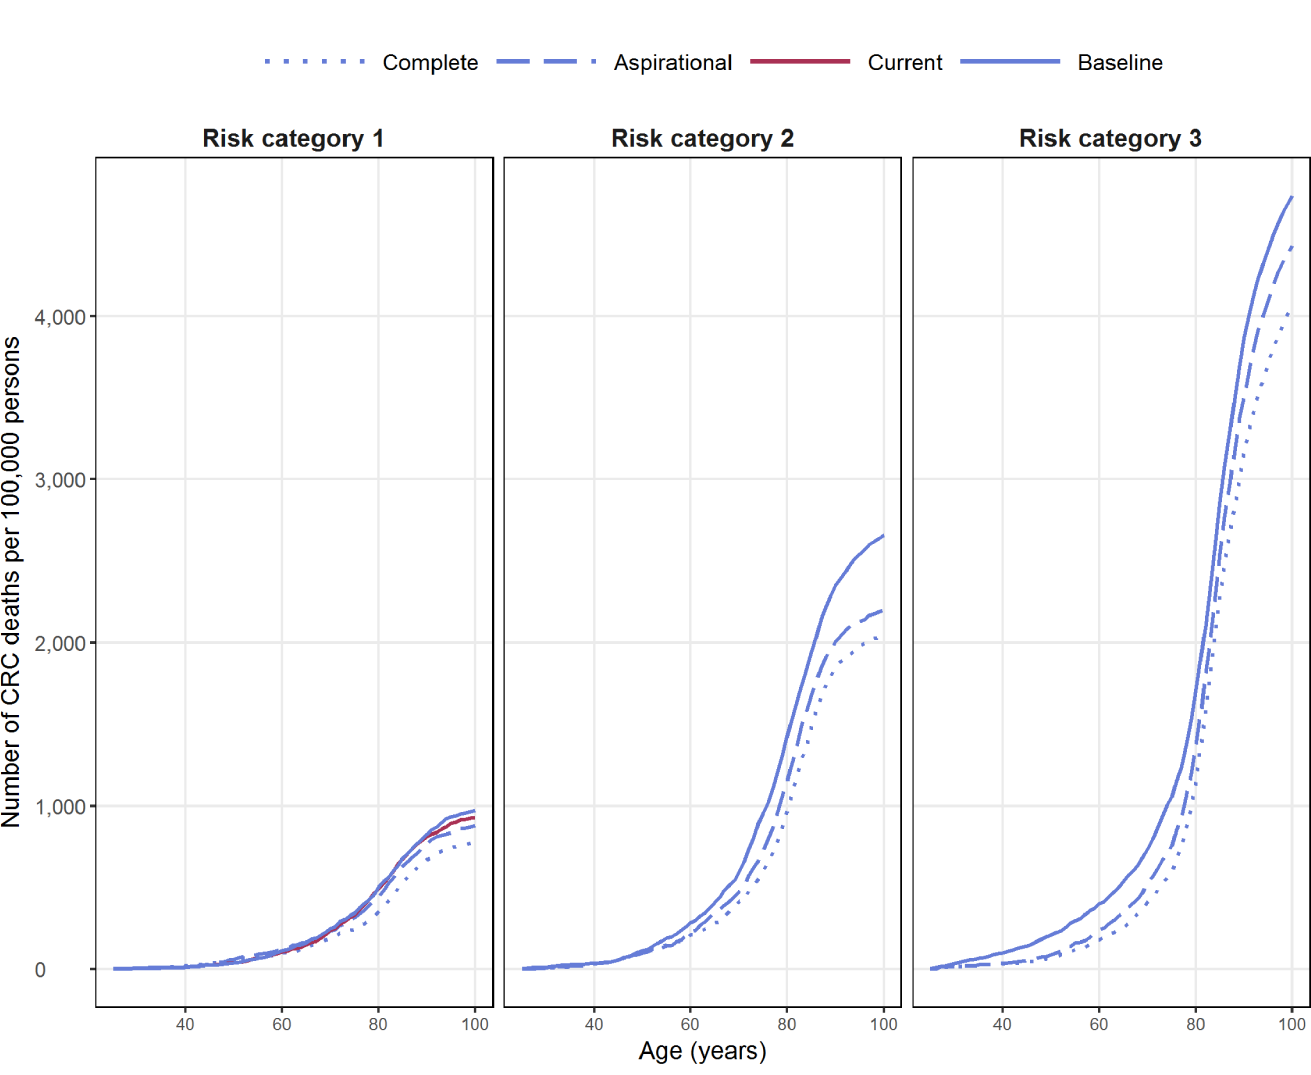
Fig 2. Deaths attributable to CRC for different screening scenarios. CRC, colorectal cancer.